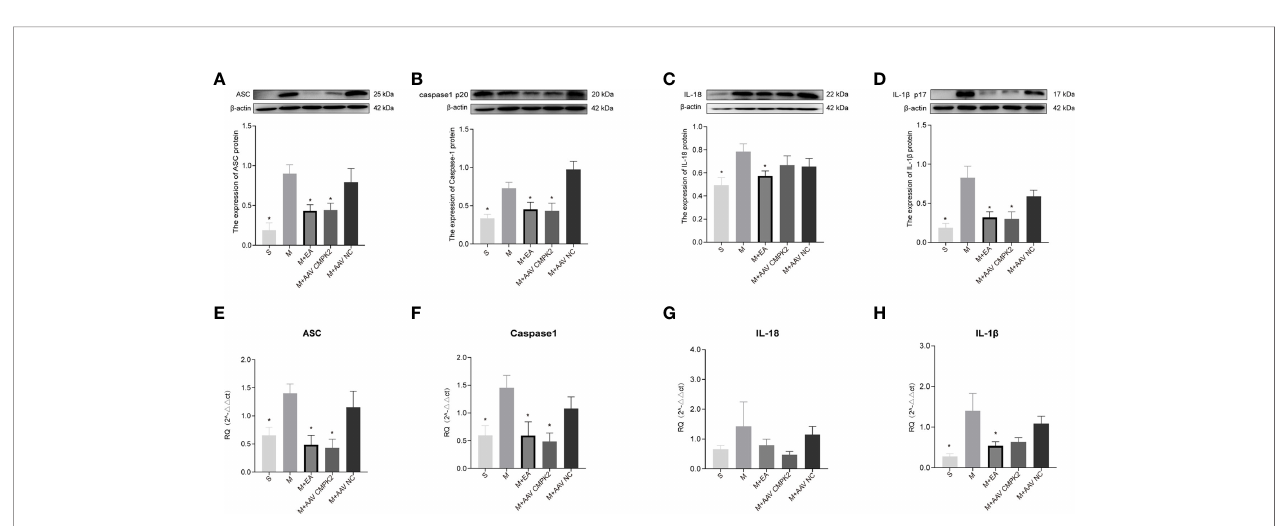
FIGURE 10 | Expression of ASC, caspase-1, IL-18, and IL-1 b in spinal cords of rats after CMPK2 knockdown. (A – D) Western blotting detection of ASC, caspase- 1, IL-18, and IL-1 b expression in the spinal cords of rats in the Sham, Model, M+EA, M+AAV CMPK2, and M+AAV NC groups showed increased expression of all in fl ammatory complexes in the Model group. Intervention with EA or AAV virus reversed this increase. Representative images show ASC, caspase-1, IL-18, IL-1 b , and b -actin protein expression. Semiquantitative analysis of ASC, caspase-1, IL-18, and IL-1 b is shown for each group at 3 days post-SCI. N = 5 rats/group. *P < 0.05 compared with the model group. One-way anOVA was used for comparison. (E – H) Gene expression of ASC, caspase-1, IL-18, and IL-1 b in the spinal cords of rats in the Sham, Model, M+EA, M+AAV CMPK2, and M+AAV NC groups using qPCR. N = 5 rats in each group. All data are expressed as the mean ± SEM. AAV, adeno-associated virus; EA,